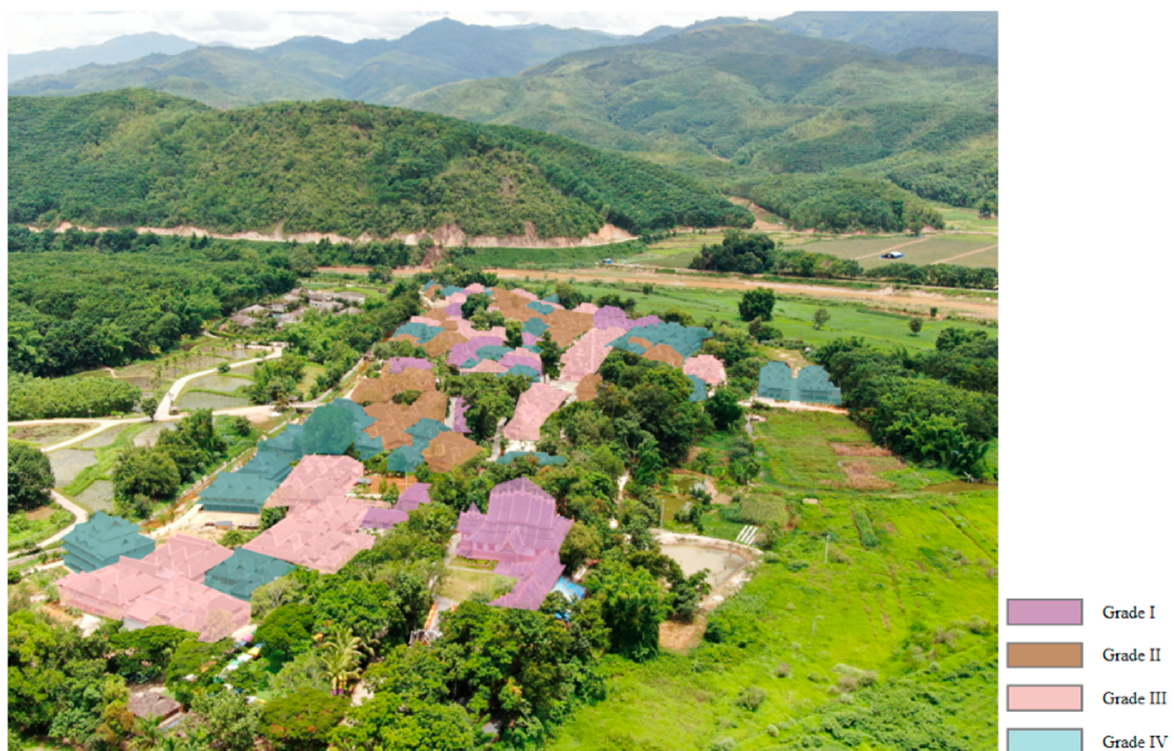
Figure 9. Distribution of residential grades in Mengjinglai village.